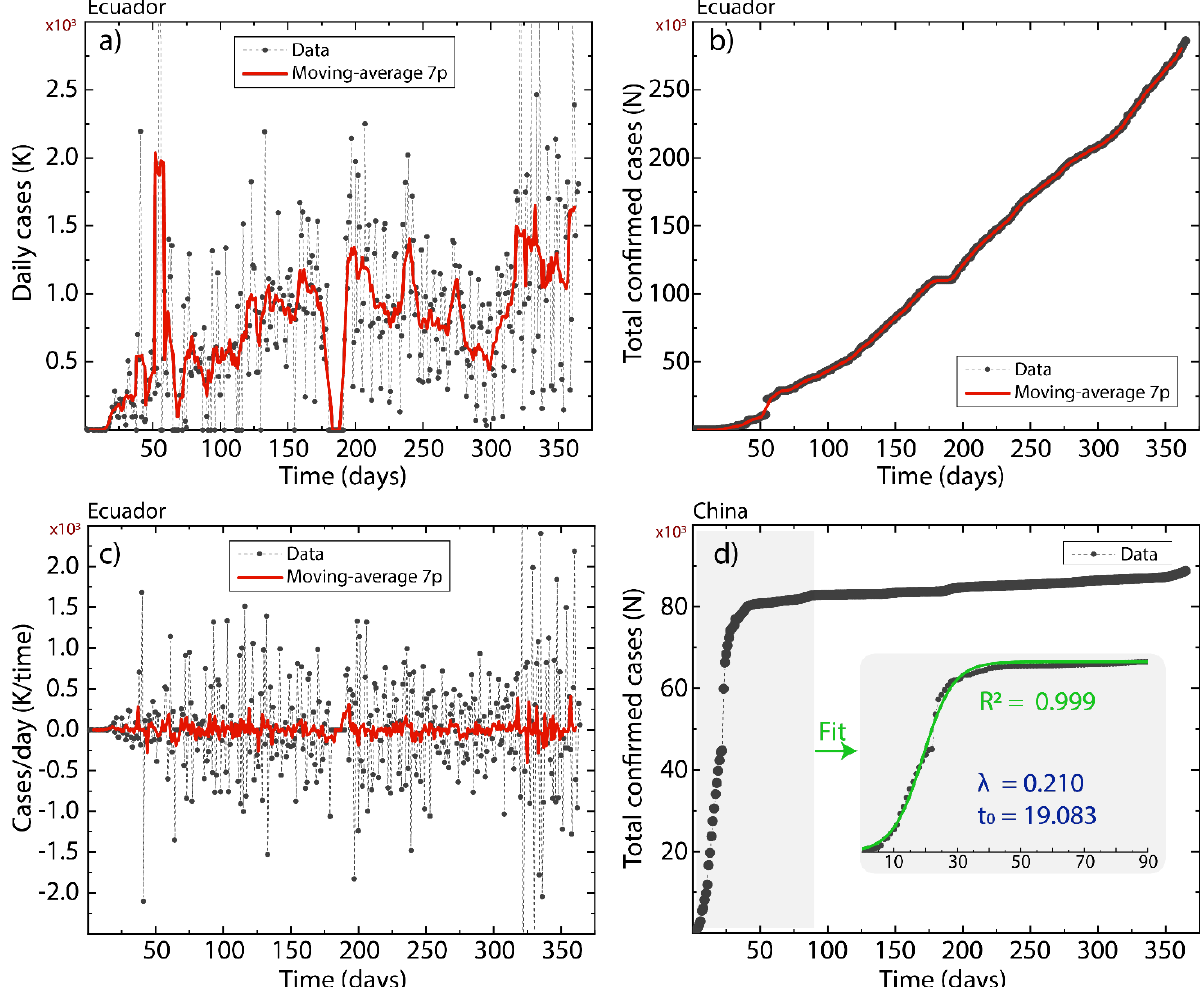
Figure 4. Ecuador: a) the number of infected people per day, b) the total number of confirmed cases reported on 02/28/2021, and c) the forward differential method applied to the daily reported cases. China: d) the total number of confirmed cases reported on 12/31/2020. Data are represented in black and the 7-point average data in red. The inset in Figure 1d shows the fit of China data using the discrete logistic